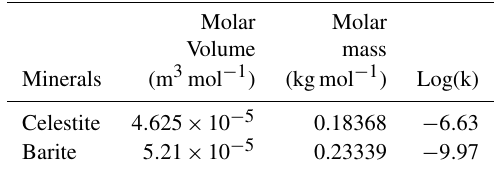
Table 1. Applied mineral properties based on PHREEQC phreeqc.dat database and Poonoosamy et al.